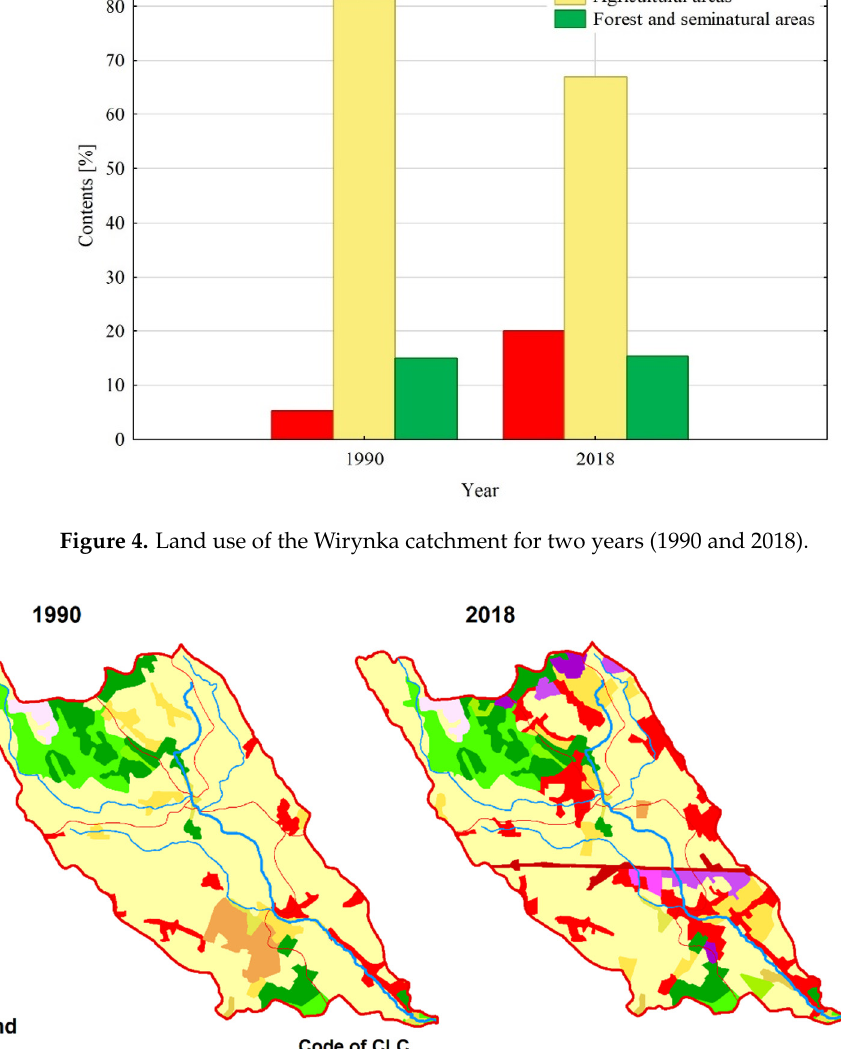
Figure 5. Land use of the Wirynka sub-catchment for two years (1990 and 2018).